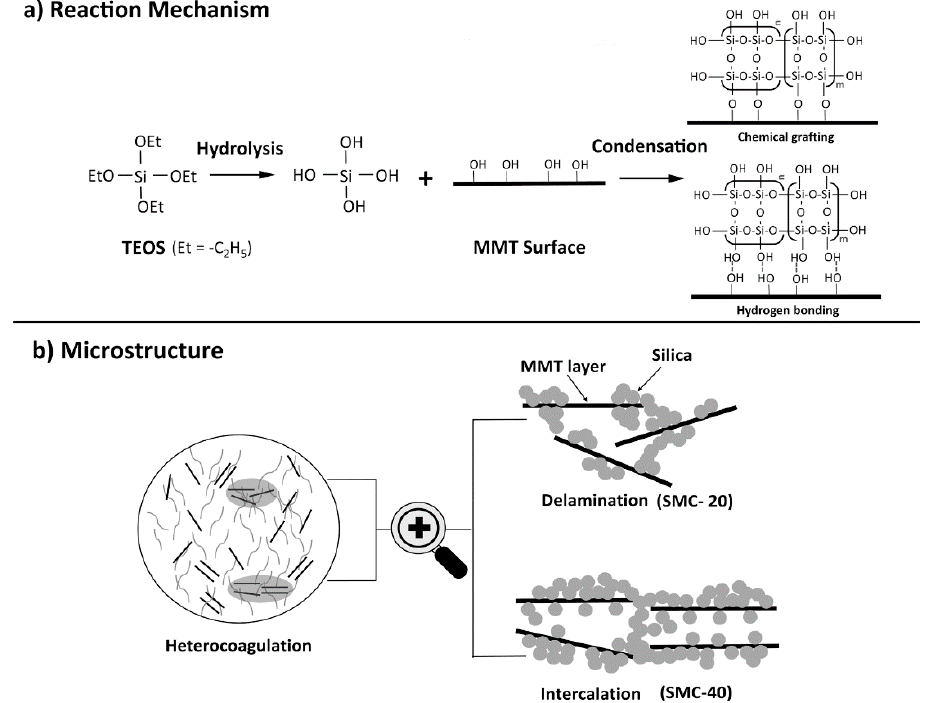
Figure 7. Schematic of reaction mechanism ( a ) and microstructure ( b ) of silica/MMT nanocomposites.